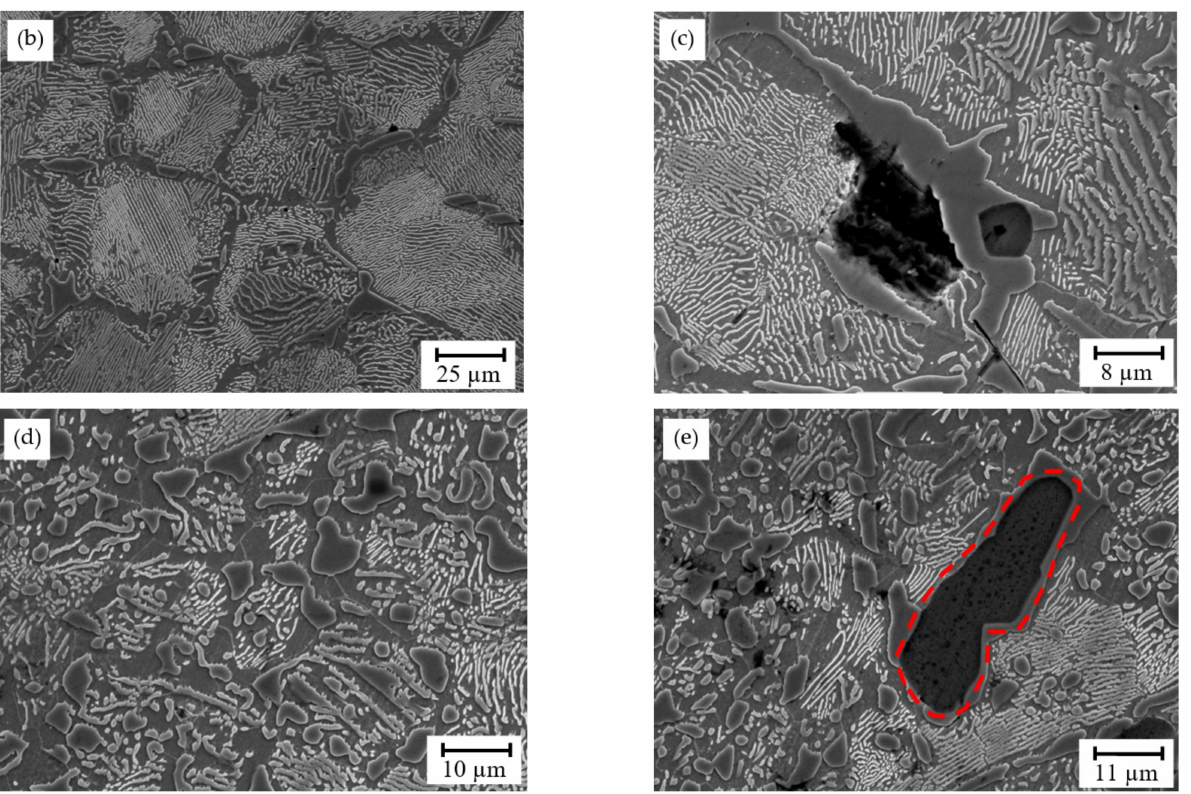
Figure 3. Microstructure of the hypereutectoid steel with 1.8% C. ( a )—the as-cast state, the carbide mesh areas; ( b )—after double normalizing; ( c )—after triple normalizing; ( d )—after annealing; ( e )— manganese sulfides. Etching with 4% HNO 3 solvent.